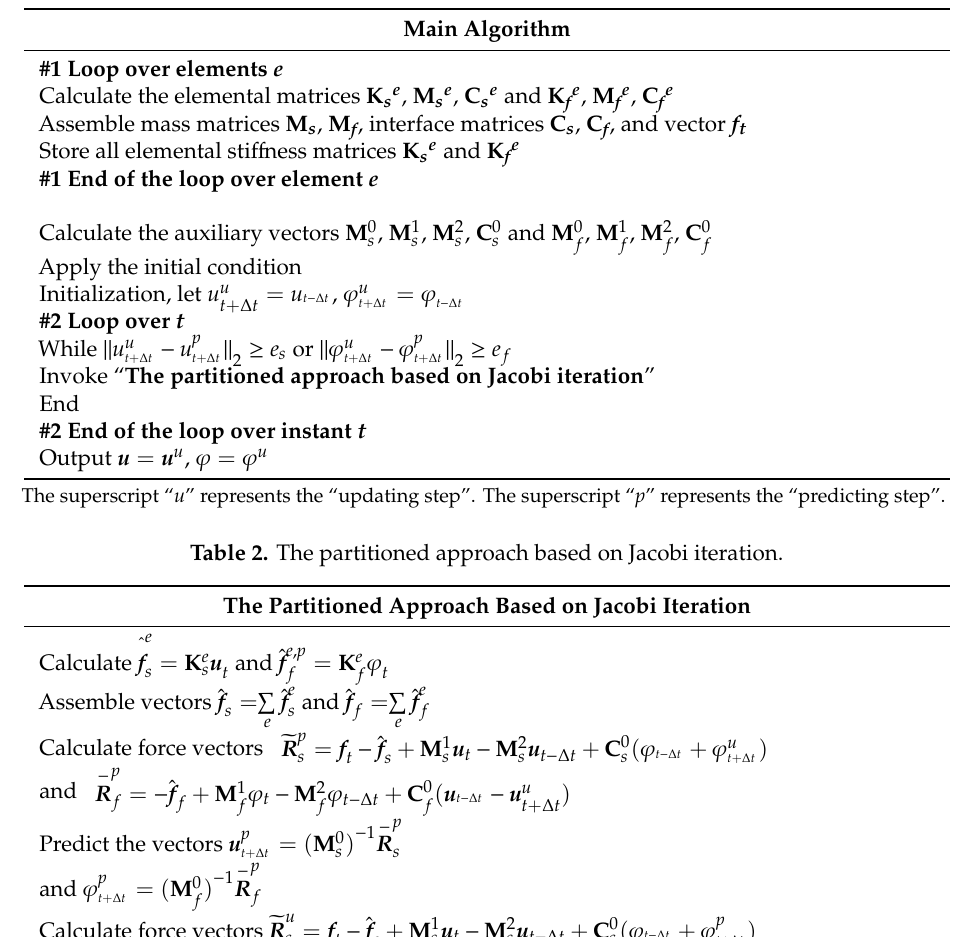
Table 1. Main Algorithm.